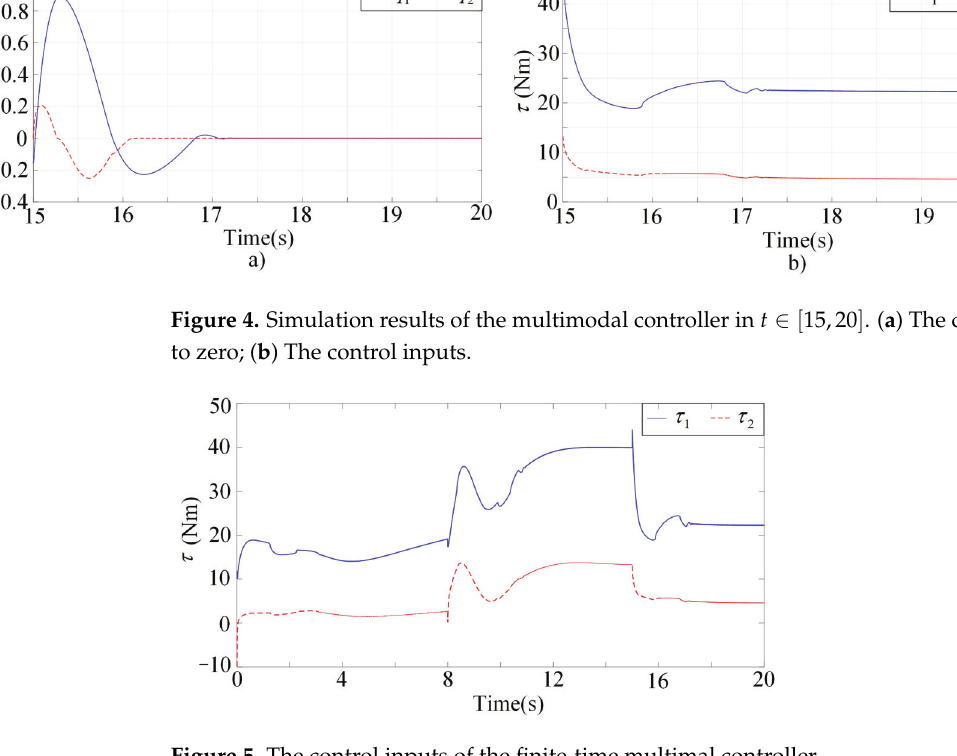
Figure 5. The control inputs of the finite-time multimal